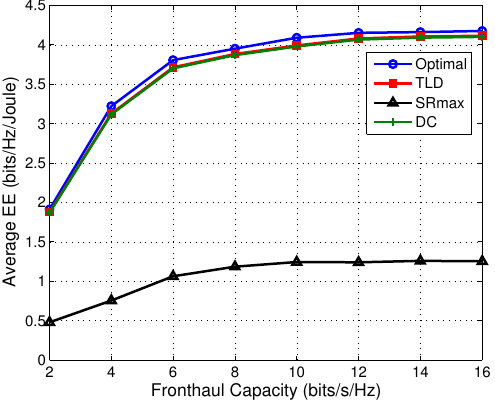
Figure 3. Average EE at various fronthaul capacities.